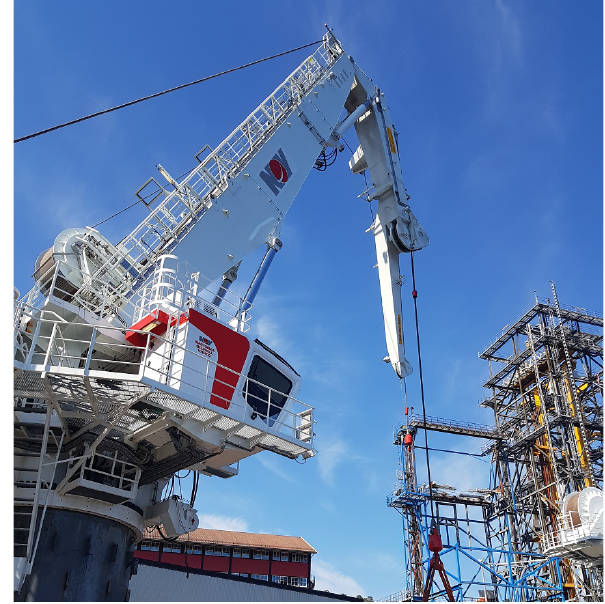
Figure 4: Photo of the crane used for testing.